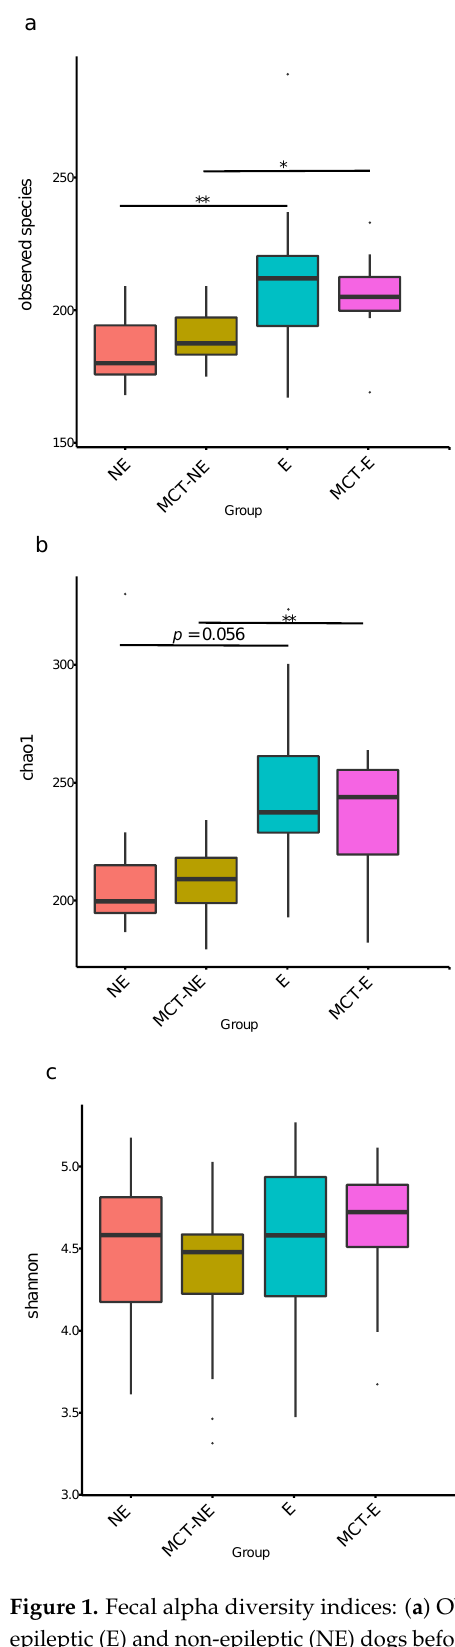
Figure 1. Fecal alpha diversity indices: ( a ) Observed Species; ( b ) Chao1; ( c ) Shannon, measured in epileptic (E) and non-epileptic (NE) dogs before (D0) and after the MCT diet (D30). Asterisks indicate significance between groups (* p < 0.05; ** p < 0.01).